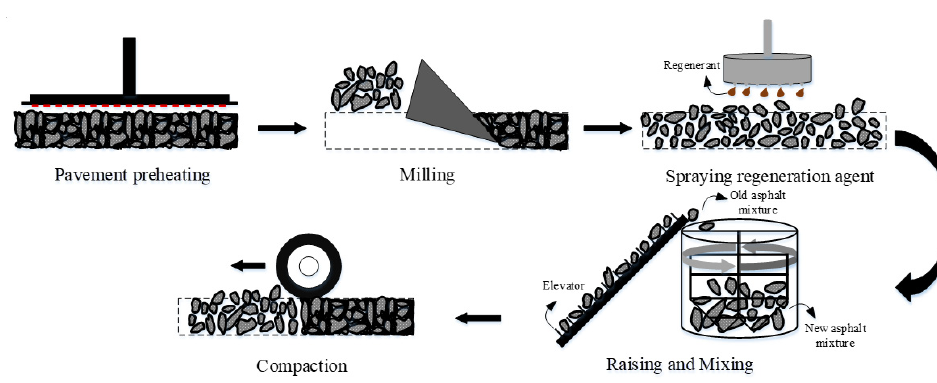
Figure 4. Hot in-place recycling process.